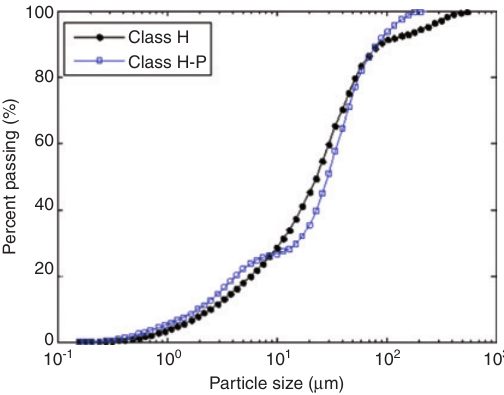
Figure 1: Particle size distributions of Class H and Class H-P